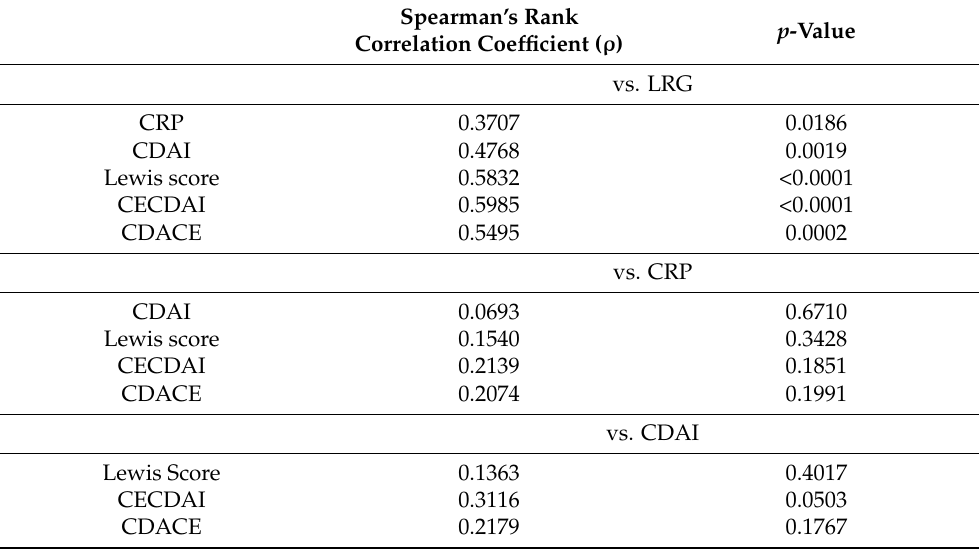
Table 4. Correlation of SBCE scores and the values of LRG, CRP, and the